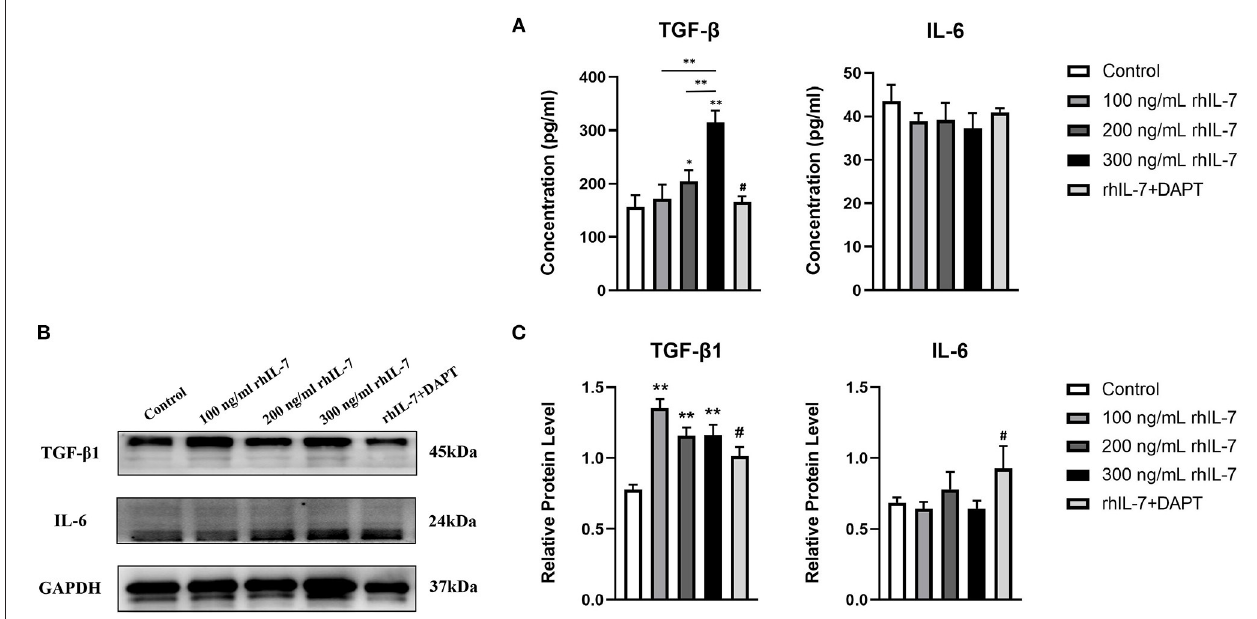
FIGURE 3 | Effect of rhIL-7 on inflammatory factors related to the immune response in hPDLCs. (A–C) After hPDLCs were treated with different concentrations of rhIL-7 for 24h, the concentration and protein level of TGF- β and IL-6 in the supernatants of each group were detected by ELISA and WB. n = 3, * p < 0.05. ** p < 0.01. # DAPT group compared with 200ng/mL rhIL-7 group, p < 0.05. hPDLCs, human periodontal ligament cells; TGF, transforming growth factor; WB, Western